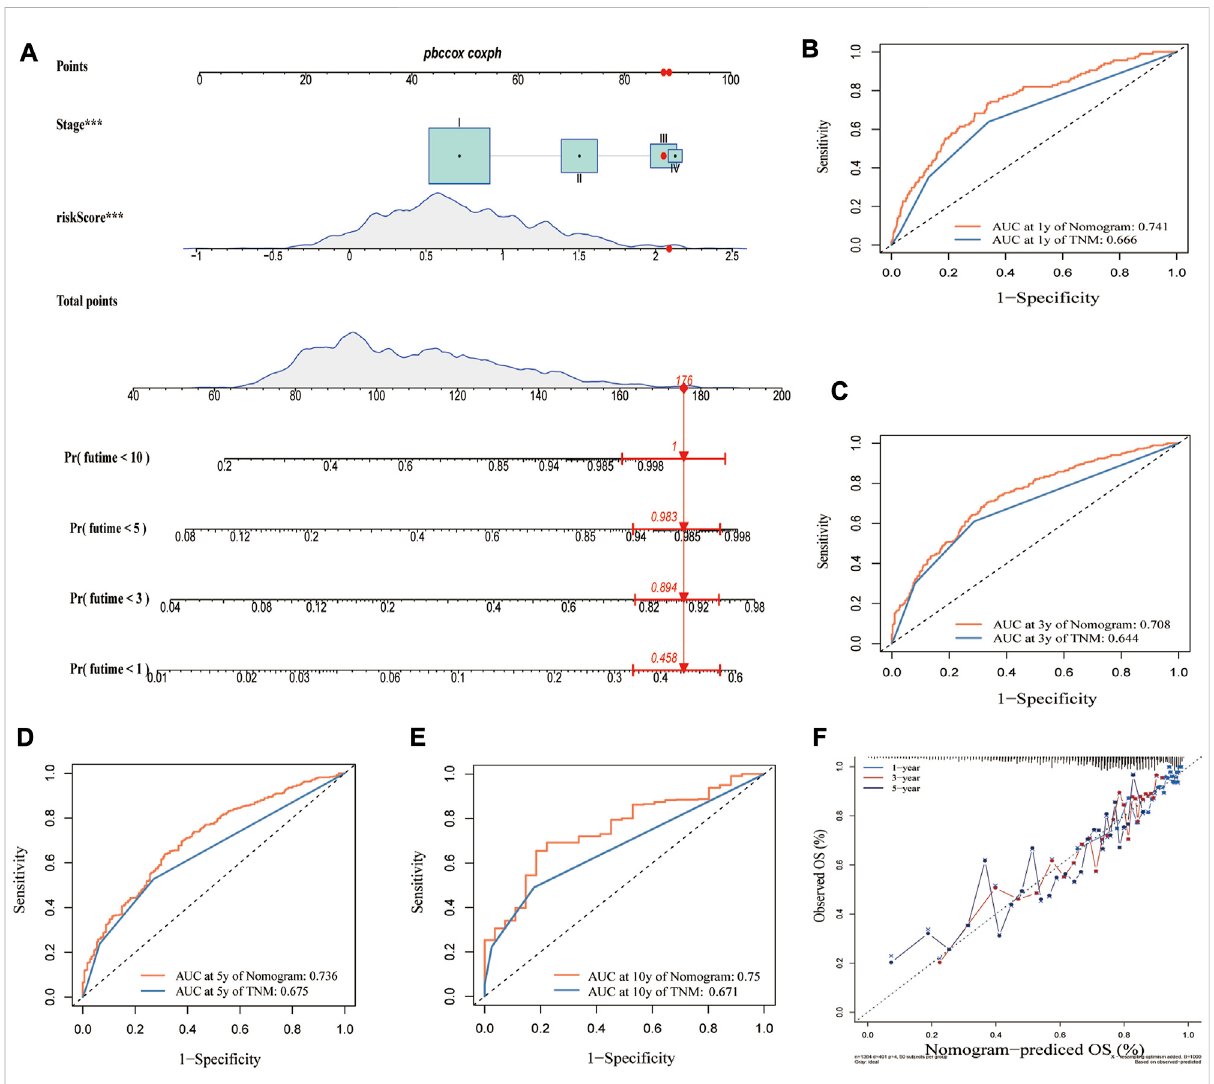
FIGURE 9 Construction of a nomogram based on CRG_score and TMN stage. (A) Nomogram for predicting the 1-, 3-, 5-, and 10-year OS of LUAD patients in the merged cohort. Comparing AUCs for the nomogram and TNM stage in predicting OS at (B) 1 year, (C) 3 years, (D) 5 years, and (E) 10 years in the merged cohort. (F) Calibration plot of the nomogram for predicting the probability of the 1-, 3-, and 5-year